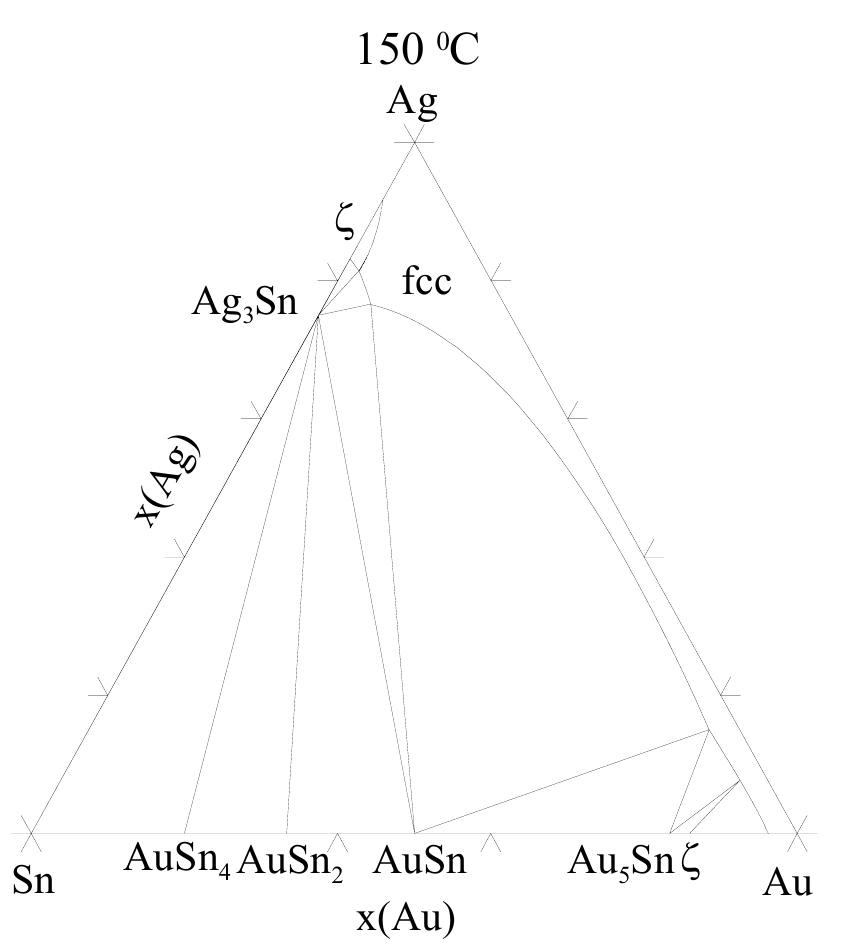
Figure 16. Isothermal section at 150 °C from the evaluated Ag-Au-Sn ternary phase